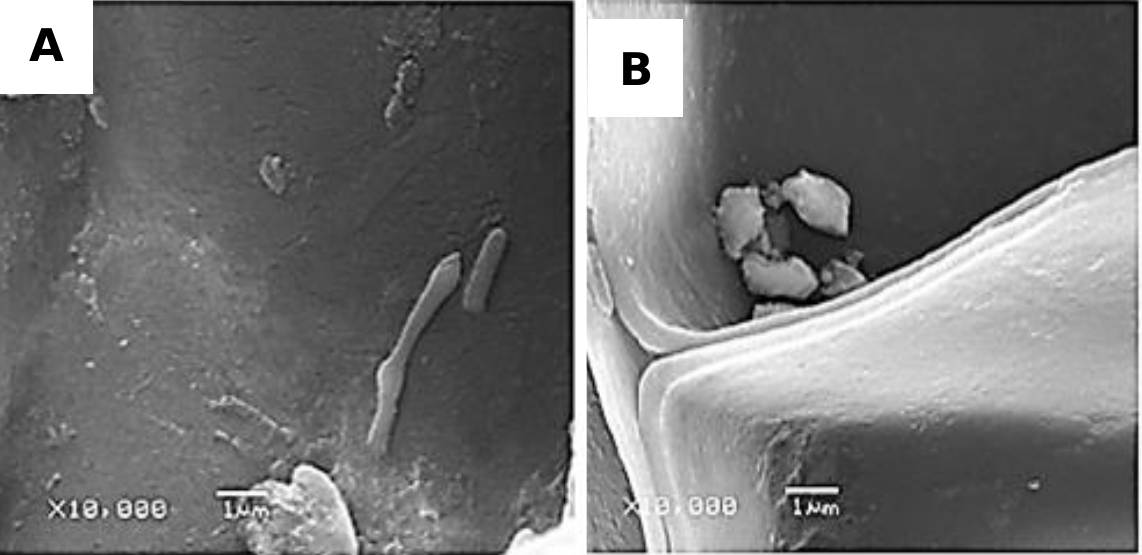
Figure 6. Representative SEM microphotographs of AgLNP-coated cork ( A ) and uncoated cork ( B ) showing microbial attachment to filter medium. Note the characteristic rod-shape of E. coli in A and the irregular B. cereus spores in B.